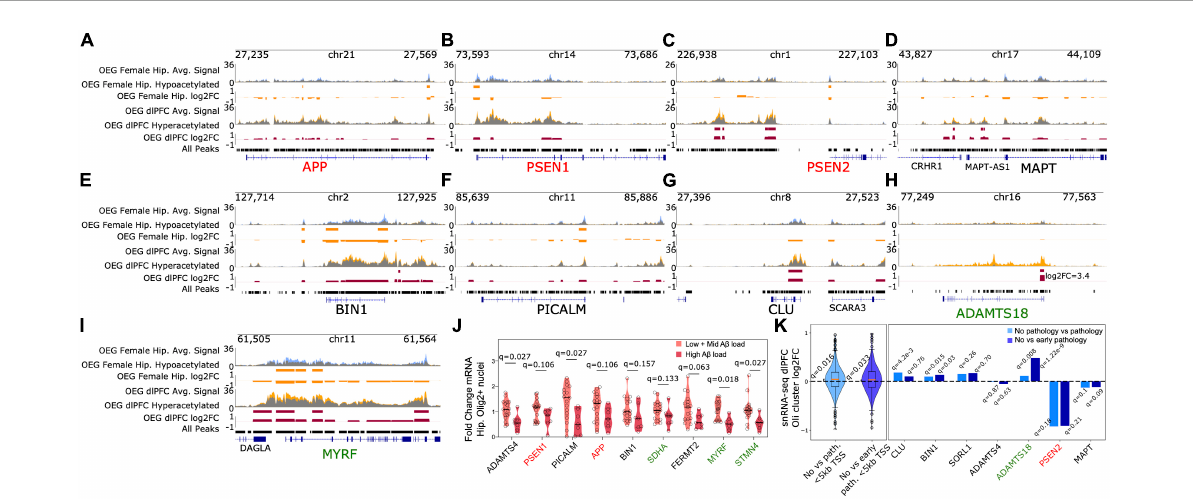
FIGURE4 EOAD and LOAD risk genes exhibit epigenomic and transcriptomic perturbations in oligodendrocytes (A–I) . Genome browser tracks displaying average H3K27ac signal in OEG samples from subjects with and without A β load (yellow and blue tracks, respectively). Regions displayed include EOAD and LOAD risk loci, as well as differentially acetylated regions near ADAMTS18 and MYRF (J) RT-qPCR of select genes annotated to DARs identified in AD OEG female hippocampus. Panel shows violin plots of gene expression measured by RT-qPCR in hippocampal Olig2+ nuclei collected from an independent cohort of AD and non-AD subjects. q-values for differential expression between high A β and low+mid A β subjects are indicated on top for each gene. Correction was applied across the 9 tests (K) left panel: comparison with existing snRNA-seq from AD dlPFC (Mathys et al., 2019) reveals an average increase in gene expression near hyperacetylated regions in OEG dlPFC. Violin plots depict log2fc values from differential expression analysis between AD and non-AD subjects in oligodendrocytes (Mathys et al., 2019). These log2fc values are derived from 500 genes annotated to the OEG dlPFC hyperacetylated DARs that reside in putative promoters ( < 5kb from TSS). Log2fc violin plots are shown for two different contrasts performed in Mathys, Valderrain et al.: no pathology vs. pathology and no pathology vs. early pathology. Q -values from t -tests (null hypothesis: mean log2fc = 0, alternate hypothesis: mean log2fc > 0) are reported for the two violin plots. Correction was applied across the two tests. Right panel: Specific genes associated with OEG dlPFC hyperacetylated DARs display increased transcription in AD. Individual log2fc values are shown. TSS distance cutoffs were not used for this right panel. FDR q -values from the differential expression analysis for each gene are also provided for both